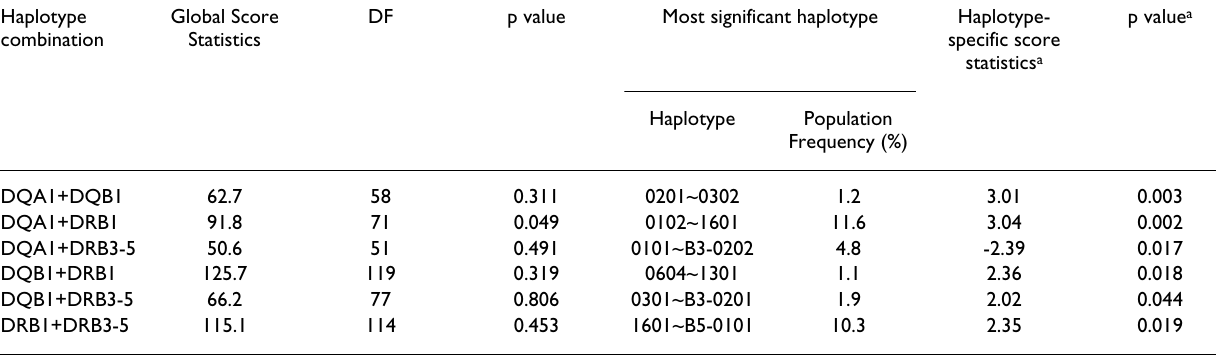
Table 7: Haplotype analyses when comparing two HLA loci Haplotype Global Score combination